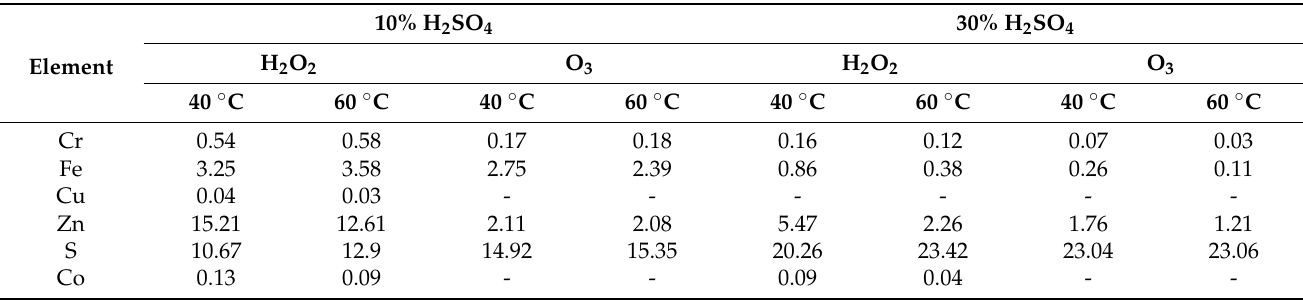
Table 4. Measured values of concentrations of elements in leaching residues for H21 samples (wt.%), ED-XRF